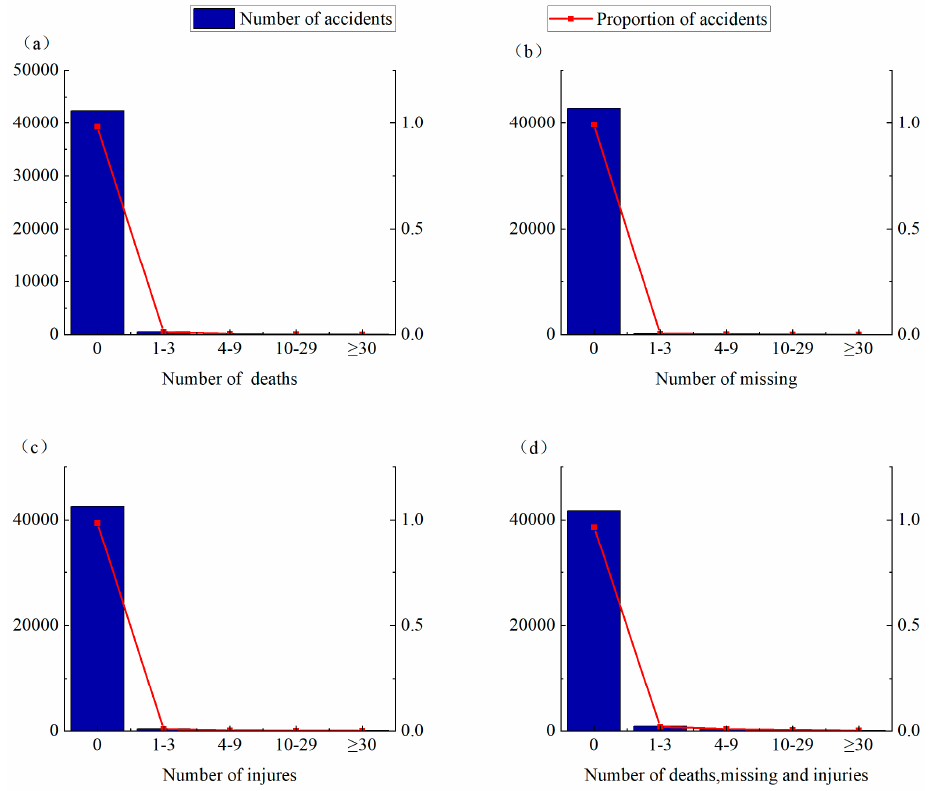
Figure 1. Distribution of maritime accidents involving ( a ) deaths, ( b ) missing, ( c ) injuries and ( d ) deaths, missing and injuries.